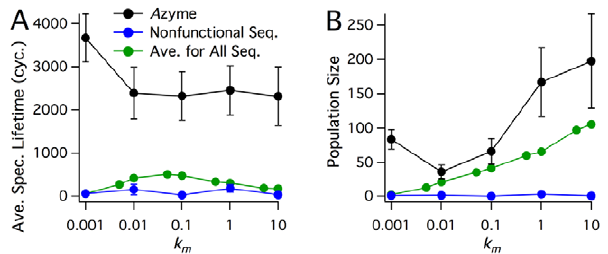
Figure 5. Selection for functional sequences. Plots illustrating the propagation of a functional A zyme, compared to nonfunctional sequences. A: Average Species Lifetime (in units of number of cycles), and B: Average Population Size. Each data point is the ensemble average over twenty-five runs, with error bars denoting the sample standard deviation. Kinetic rate constants are k s ~ 10 { 7 , k r ~ 10 { 4 , and k h ~ 0 : 1 , with a polymer diffusion rate constant of k p ~ 0 : 001 sites/cycle. The green points represent overall population statistics for realizations with no A zyme (plotted in green in Figure 4). The black points represent statistics for a single functional A zyme. The blue points represent statistics for a nonfunctional sequence introduced at the same location and cycle as in the A zyme simulations, except with no functionality.